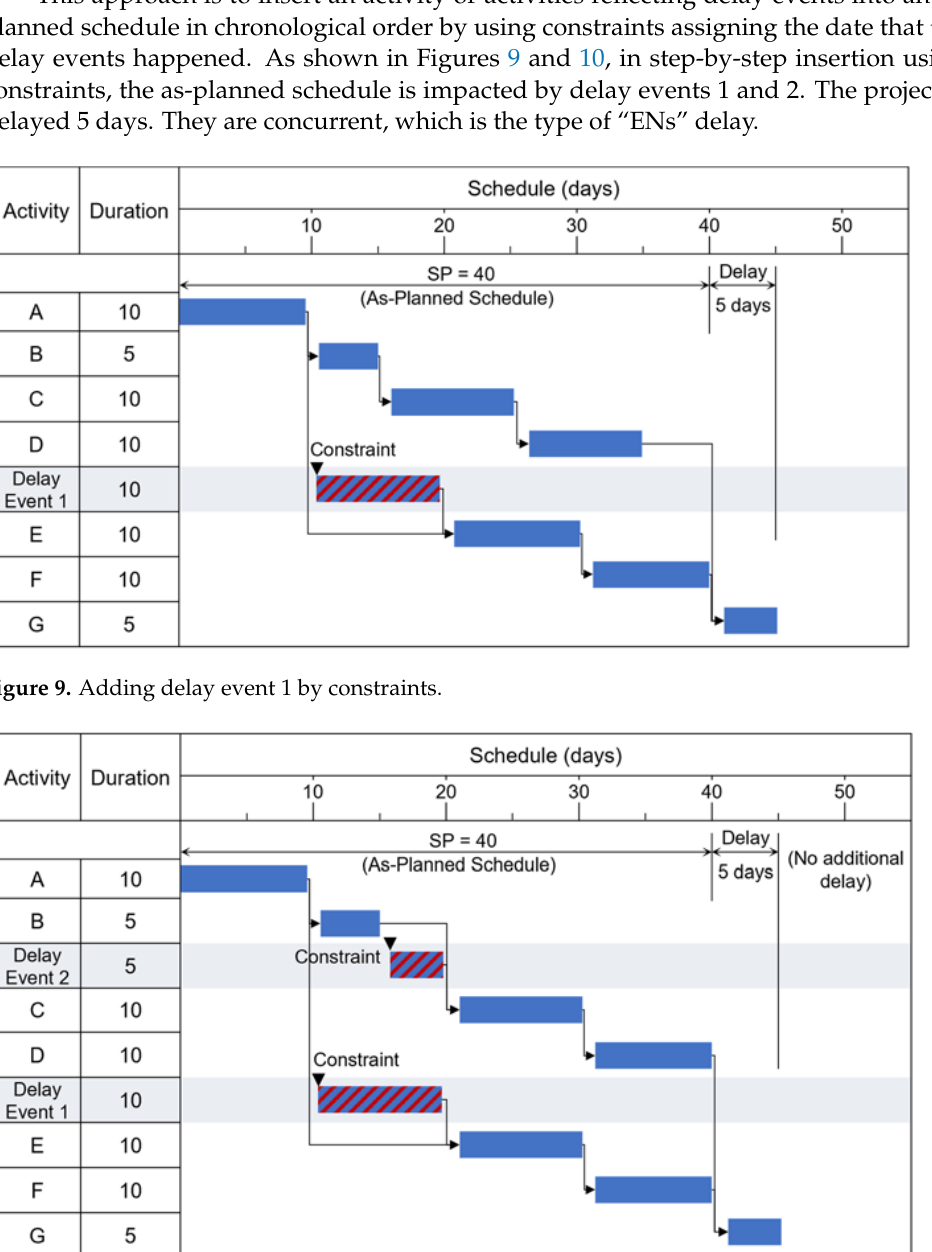
Figure 8. Impact of delay events 1, 2, and 3.